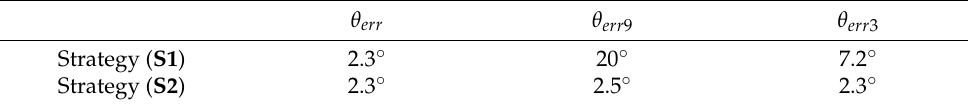
Table 3. Resulting position error (electrical angle) from strategies ( S1 ) and ( S2